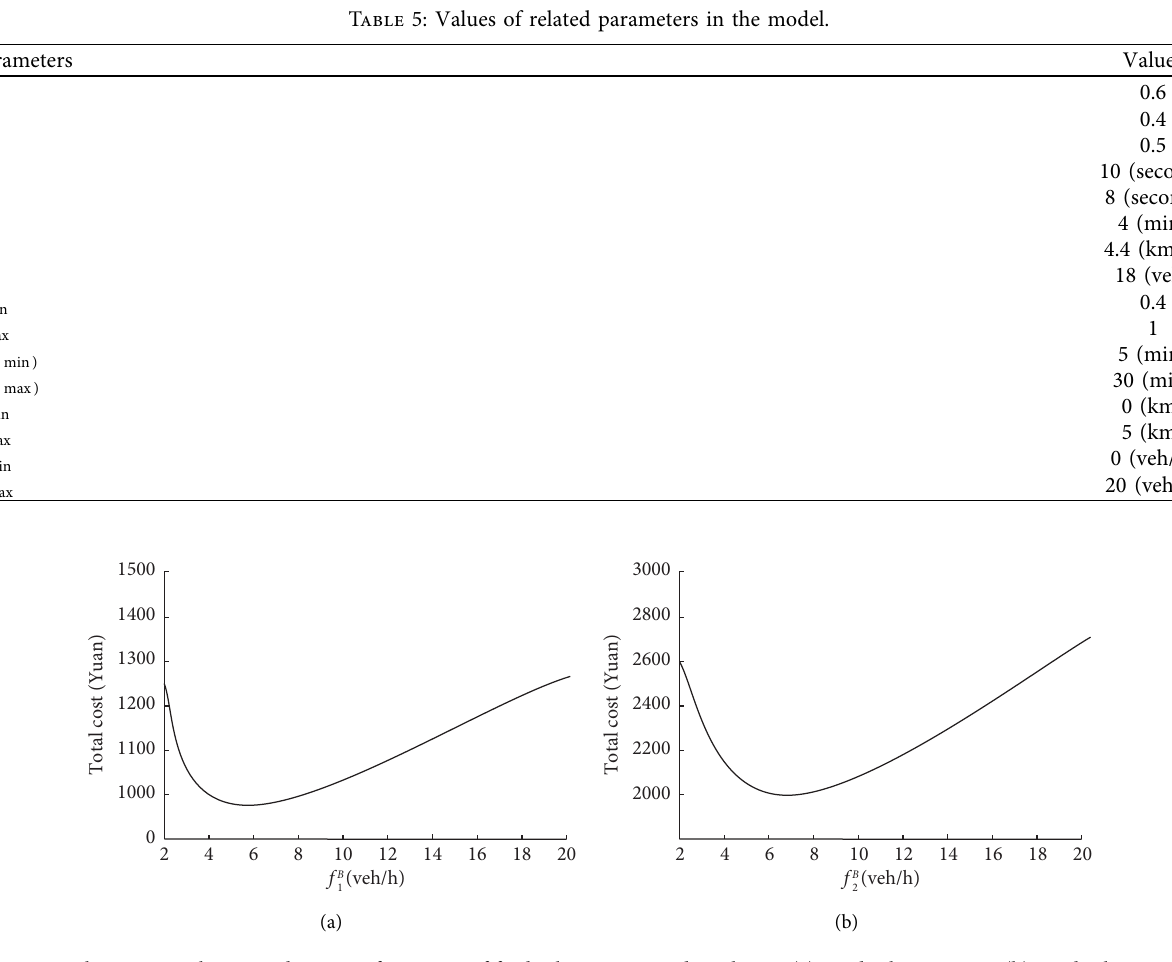
Figure 4: Relation curve between departure frequency of feeder bus routes and total cost. (a) Feeder bus route 1. (b) Feeder bus route